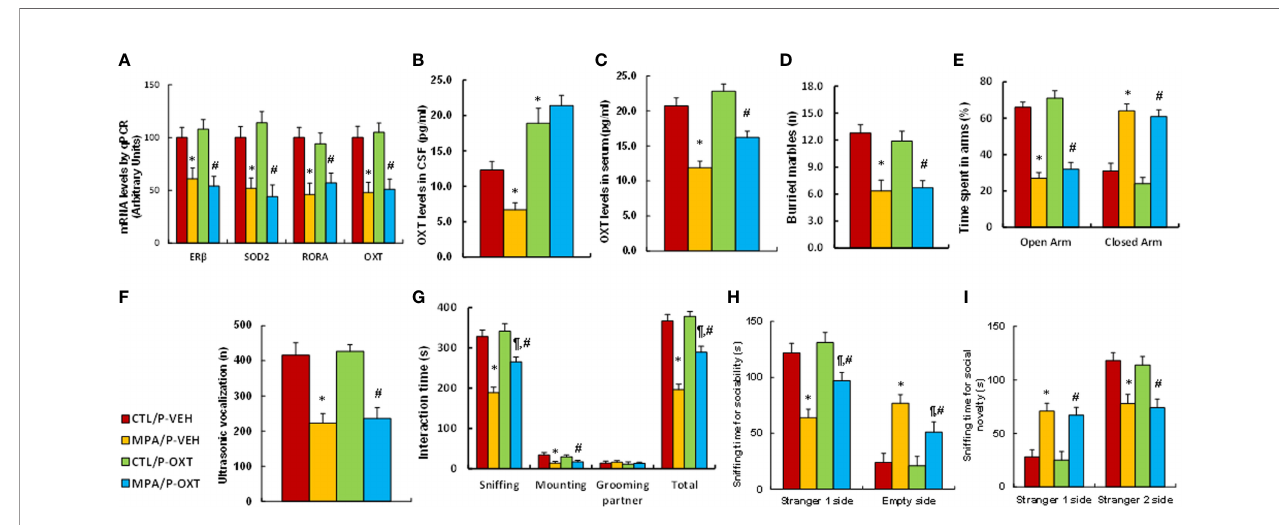
FIGURE 7 | Postnatal injection of OXT partly ameliorates prenatal MPA exposure-mediated social de fi cits in mouse offspring. The pregnant dams were treated with either control (CTL) or MPA, and the subsequent offspring received either vehicle (VEH) or OXT peptide injection through the third ventricle. The animals were then used for analysis. (A) The hypothalamic tissues were used for mRNA analysis, n=4. (B) OXT levels in CSF, n=5. (C) OXT levels in serum, n=5. (D – I) Offspring were used for animal behavior tests. (D) MBT tests, n=9. (E) EPM tests, n=9. (F) Ultrasonic vocalization, n=9. (G) Social interaction (SI) test, n=9. (H, I) Three-chambered social tests for sociability (H) and social novelty (I) , n=9. * P < 0.05, vs. CTL/P-VEH group; ¶ P < 0.05, vs. MPA/P-VEH group; # P < 0.05, vs. CTL/P-OXT group. Data were expressed as mean ±